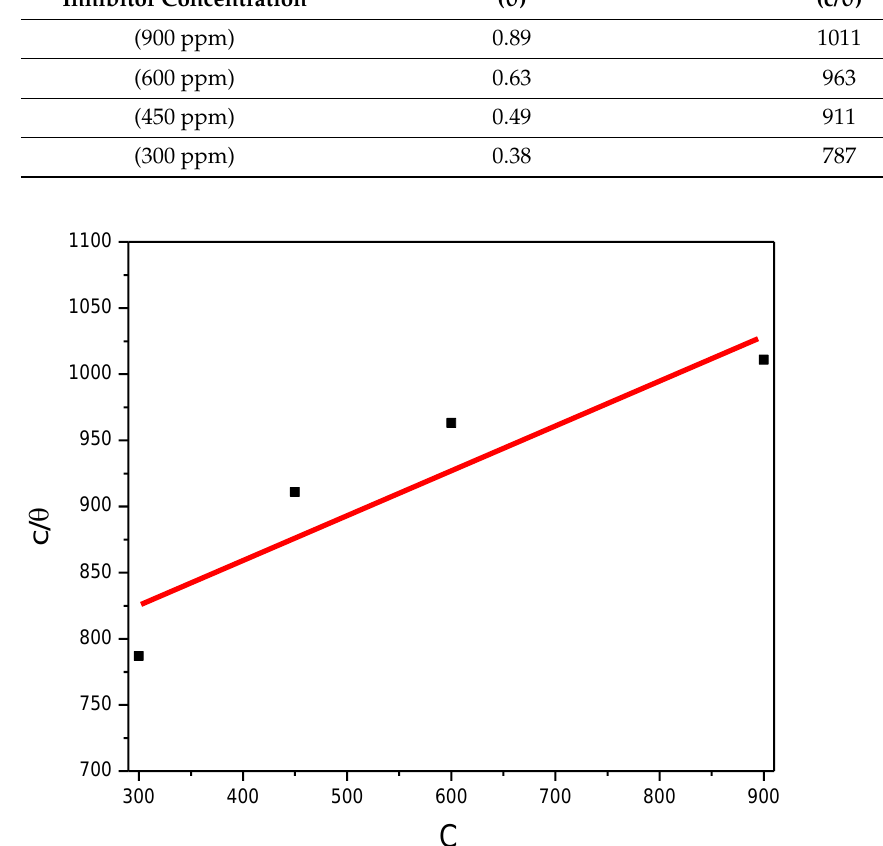
Figure 7. Fitting the Langmuir adsorption isotherm to the corrosion data for aluminium in 1 M HCl in the presence of varying amounts of the honey inhibitor.